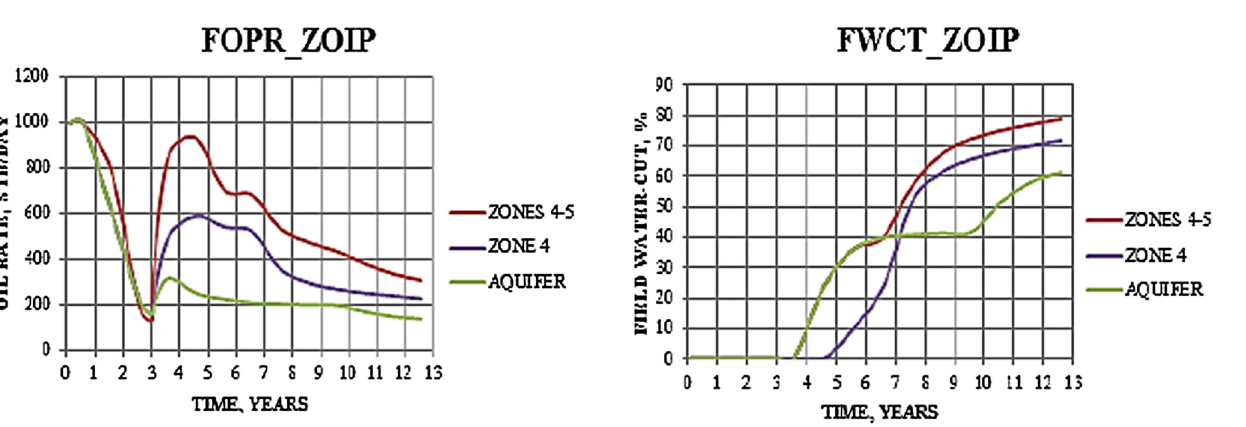
Fig. 16 Plot of field water-cut versus time for different ZoIP scenarios for the